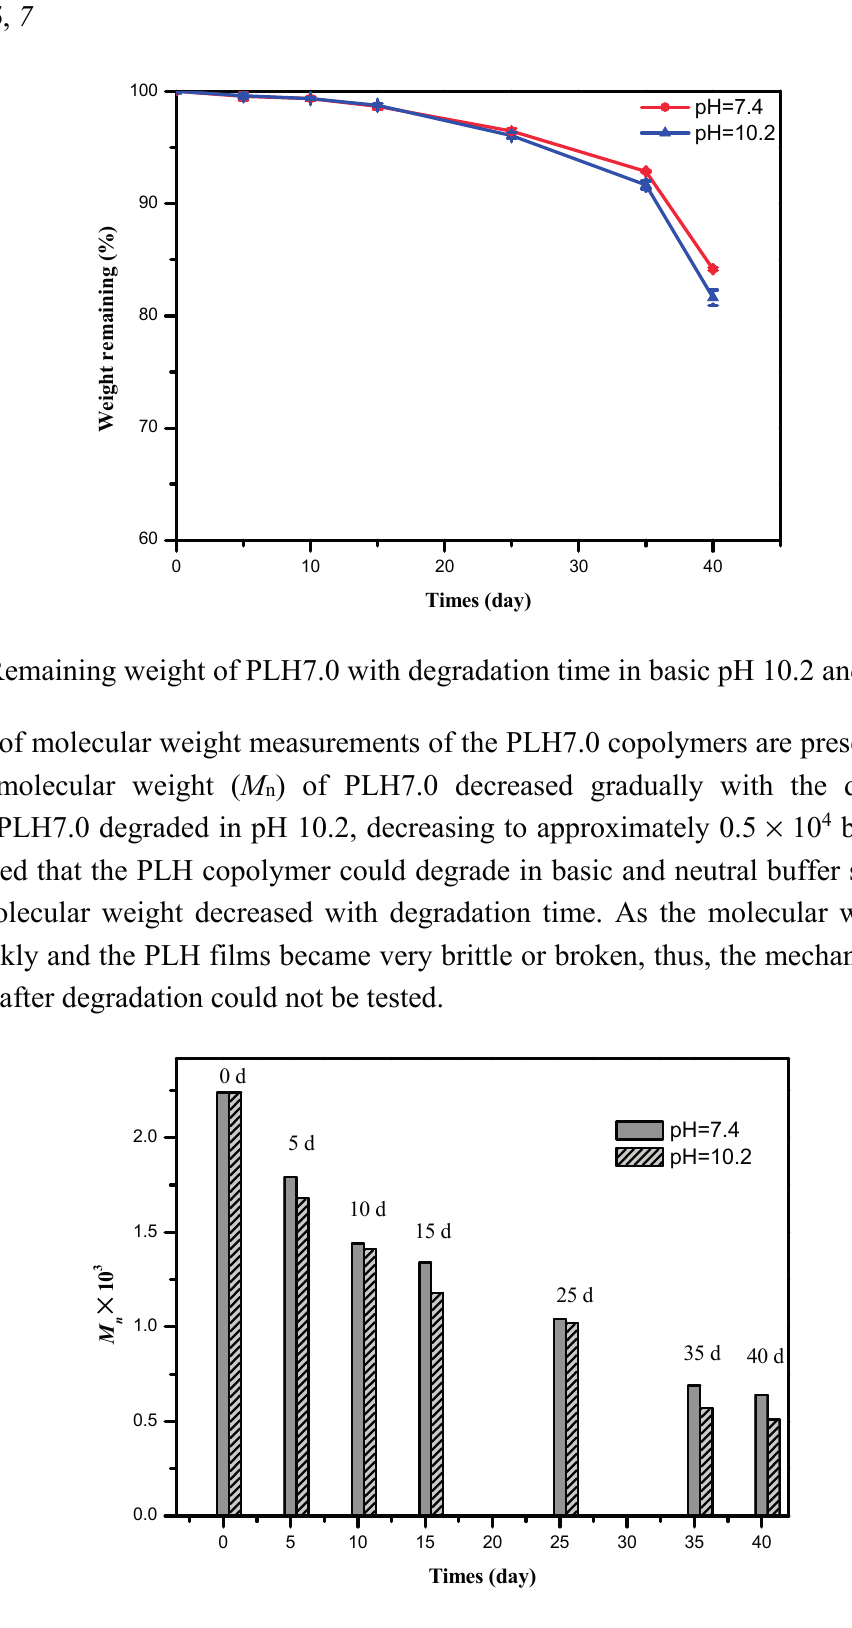
Figure 6. Molecular weight of PLH7.0 in different pH phosphate butter solutions with degradation